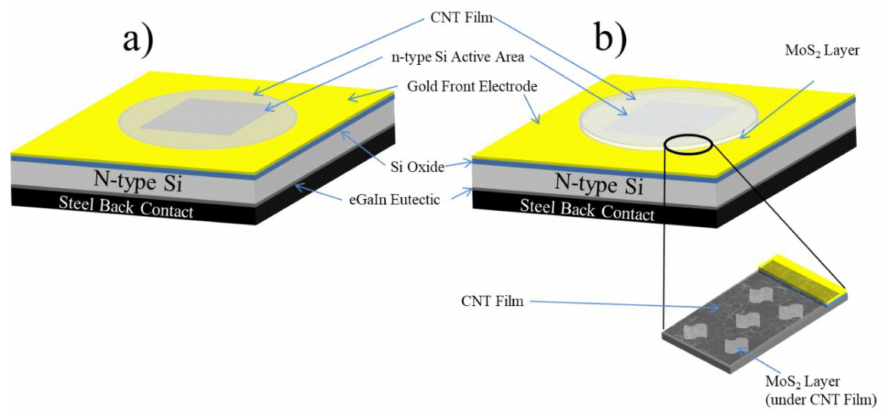
Figure 1. Schematic structure for ( a ) single-wall carbon nanotube (SWCNT)/n-Si solar cells and ( b ) SWCNT/ Molybdenum disulphide (MoS) 2 /n-Si layered solar